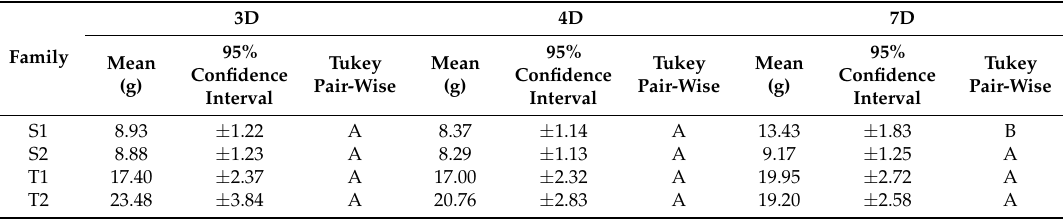
Table 5. Summary of seedling total dry matter yield (g) by rainfall and family.